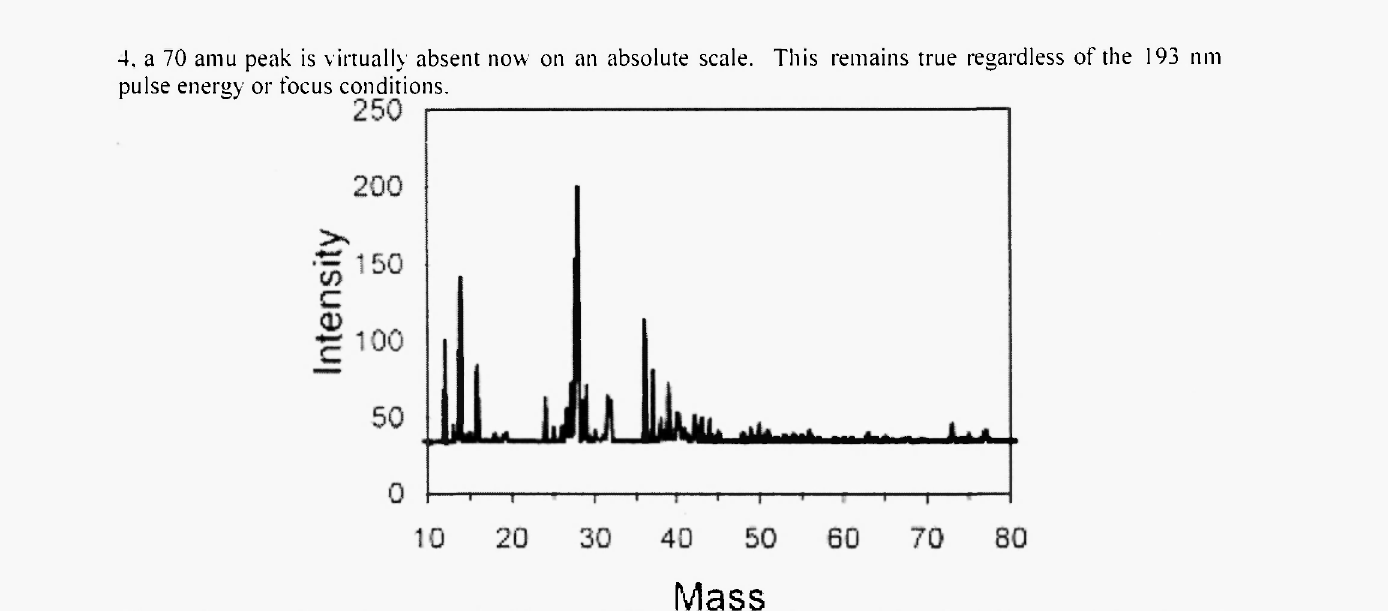
Figure 4. Mass spectrum ot azidotrimethylsilane photoproducts using only 193 nm pulses, directed in the photoionization region of the molecular beam.